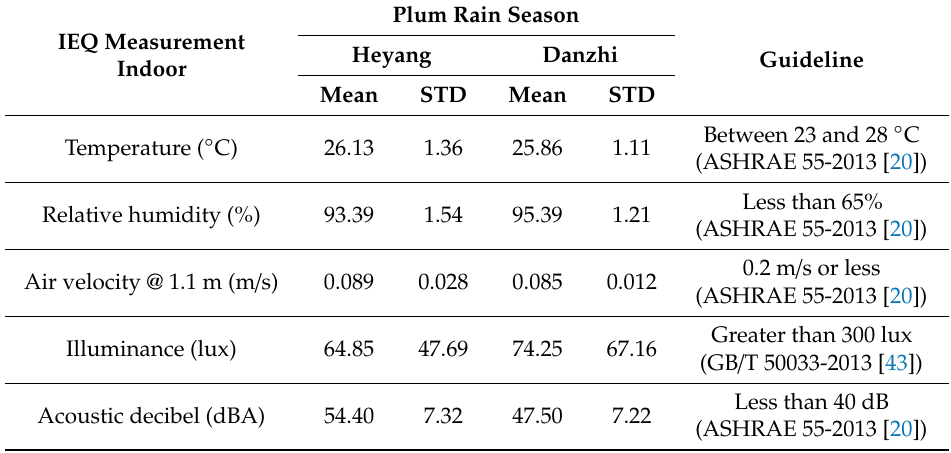
Table 4. Summary of measured indoor environmental quality (IEQ) data and the guidelines adopted in this